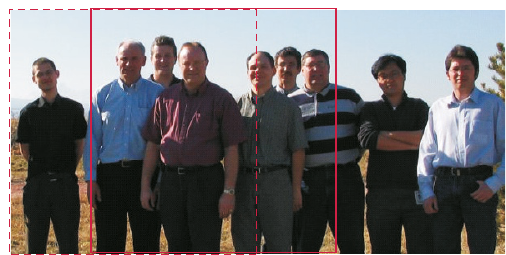
Figure 9: Data reuse in the overlapping region of the search area for motion